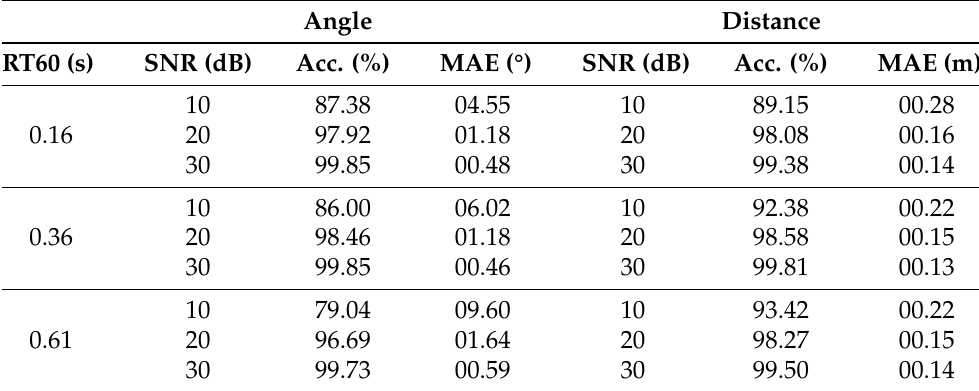
Table 11. The average Acc. and MAE of angle and distance estimation by CNN-R in a real acoustic environment where SNR = 10 dB, 20 dB, and 30 dB, and RT60 = 0.16 s, 0.36 s, and 0.61 s, respectively.